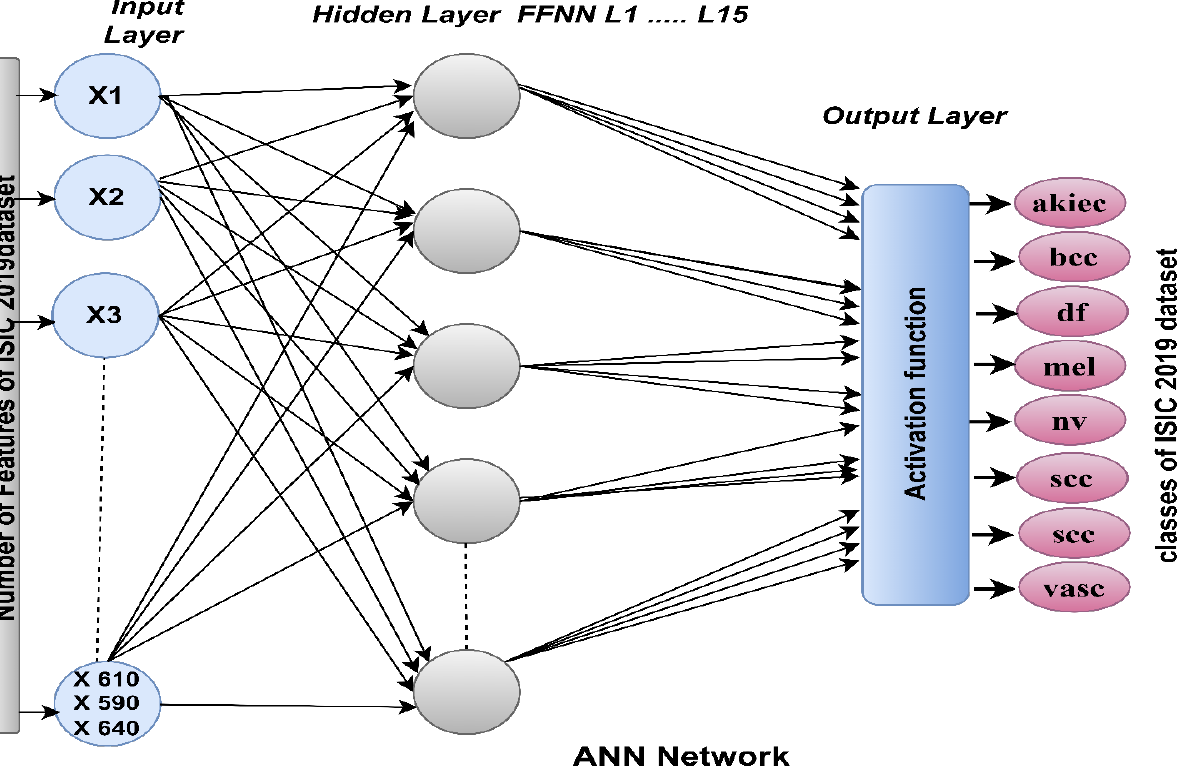
Figure 3. ANN structure for analyzing dermatoscopic images to diagnose the skin lesions of the ISIC 2019 dataset.